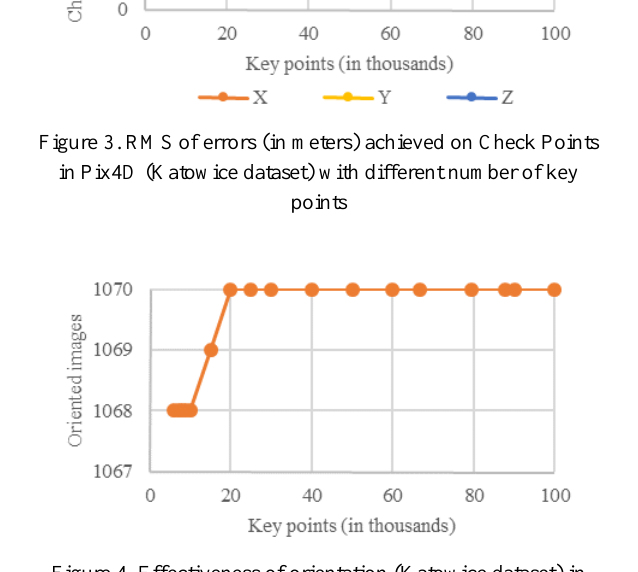
Figure 4. Effectiveness of orientation (Katowice dataset) in Pix4D with different number of key